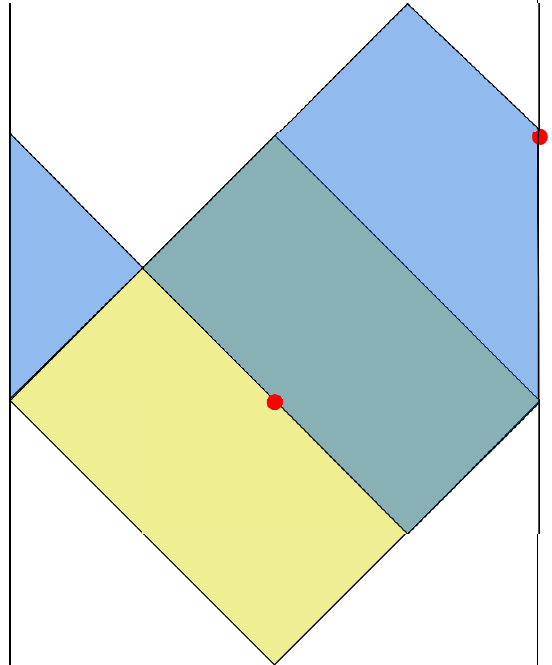
Figure 4 . Boundary version of (cid:12)gure 3, showing the action of the null inversion (2.21) on Minkowski patches. The left and right sides of the diagram are identi(cid:12)ed to make the Lorentzian cylinder. The ( u 0 ; v 0 ) coordinates cover the Minkowski spacetime shown as a yellow diamond. The coordinates ( u; v ) cover the shifted patch, shown as a blue diamond. These overlap in the region v 0 > 0, v < 0. The shockwave hits the boundary at the red dots; it is created at the origin of the yellow diamond, which is on I (cid:0) of the blue